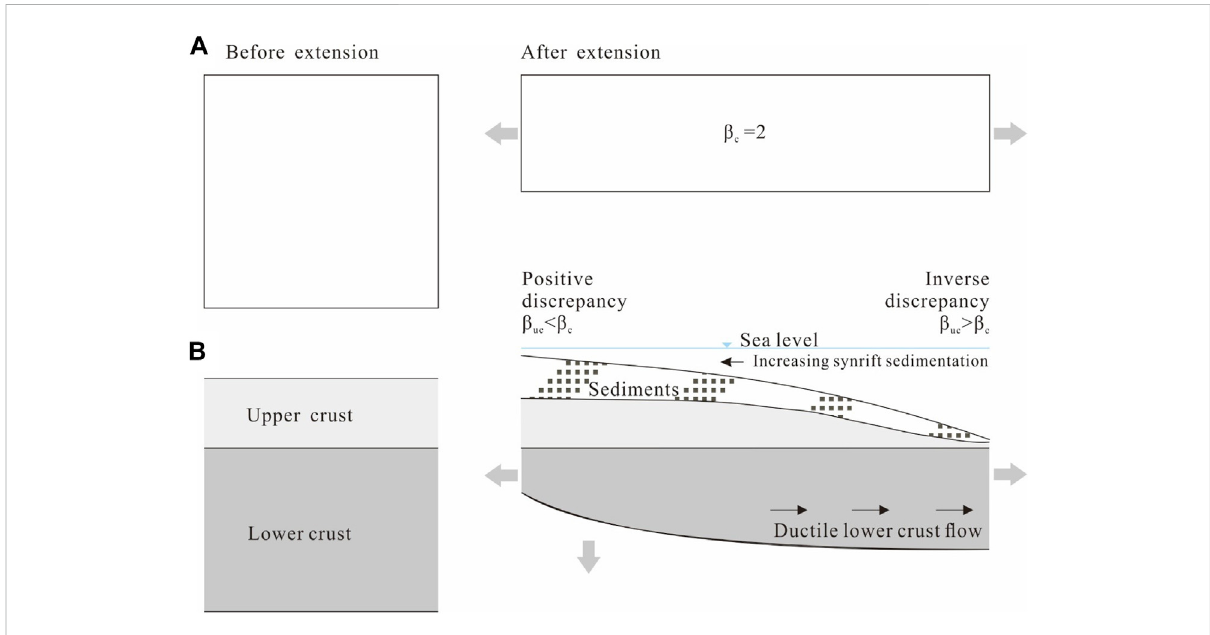
FIGURE 9 (A) Cross sectional area remains constant before and after extension; (B) Schematic illustrations showing that the pressure by variation of sediment thickness drives the ductile lower curst fl